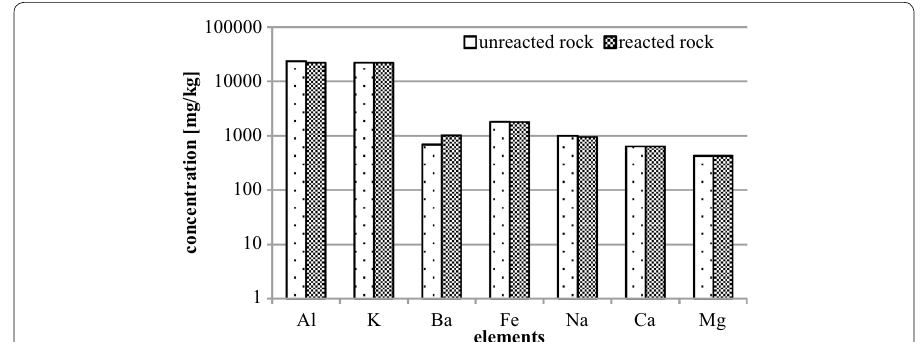
Fig. 20 Major element content of the initial sandstone sample 7 and the reacted sandstone sample 7.2